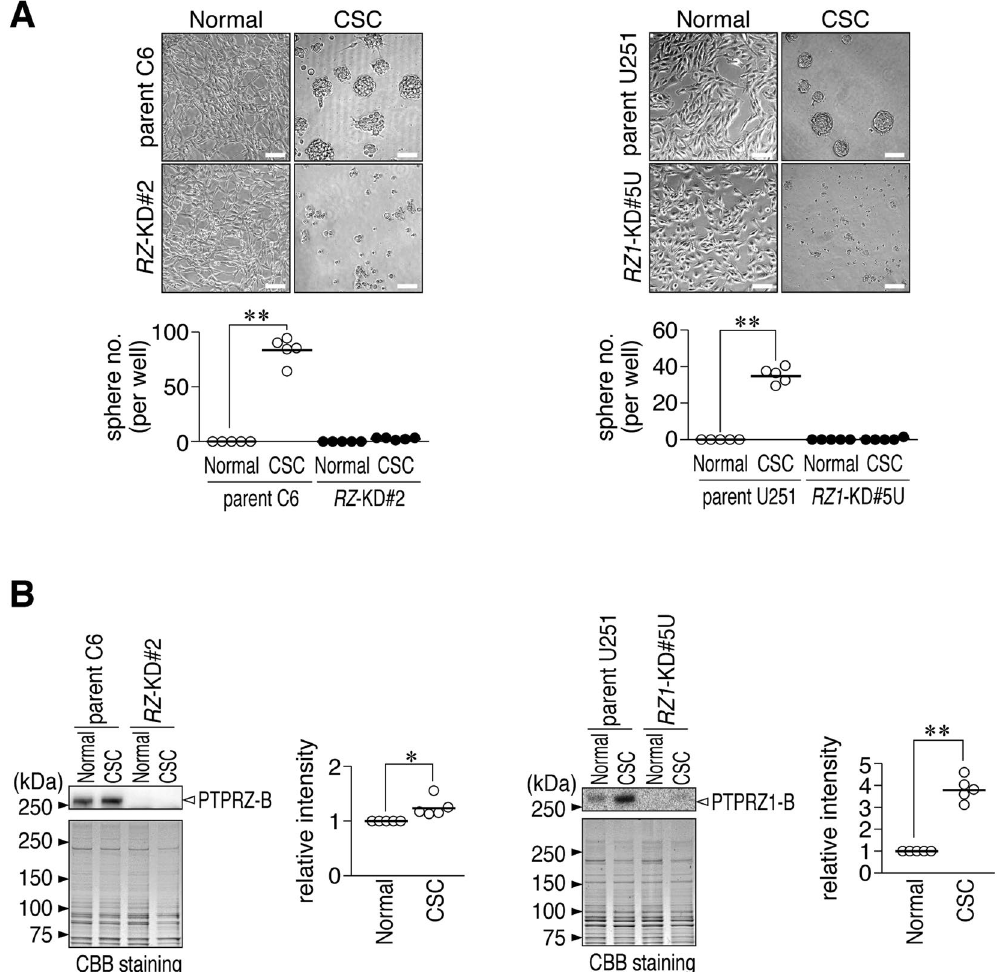
Figure 1. Decreased cell sphere formation of stem cells in Ptprz -knockdown glioblastoma cells. ( A ) Sphere formation assay. C6 and U251 cells (parent), Ptprz- knockdown C6 cells ( RZ -KD#2), and PTPRZ1 -knockdown U251 cells ( RZ1 -KD#5U) were cultured in serum-free cancer stem cell medium for 7 days (CSC) or DMEM supplemented with 10% FBS for 3 days (Normal). Scale bars, 100 µ m. Images are representative of five independent cultures. The plot shows the number of cell spheres as the mean value. ** P < 0.01 (Student’s t -test). ( B ) PTPRZ expression. Cells cultured as in A were analyzed by Western blotting with anti-PTPRZ-S (for the detection of rat PTPRZ) and anti-RPTP β (for human PTPRZ1). The blot is representative of five independent cultures. The plot shows the arbitrary densitometric units of the staining intensity of PTPRZ-B relative to the parental cells cultured in normal serum-containing medium. * P < 0.05, ** P < 0.01 (Student’s t -test). Full-length blots and gels are presented in Supplementary Fig.